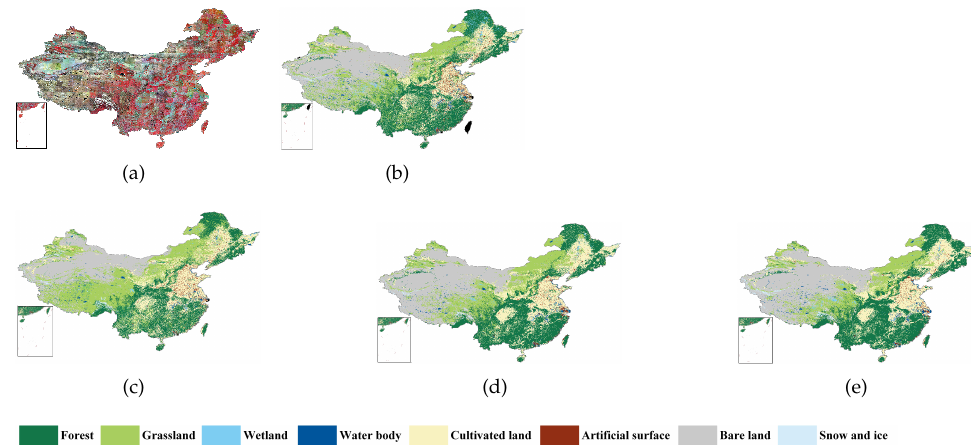
Figure 9. Original Landsat images for 2010 and corresponding land cover maps, where ( a ) is composed of 1056 Landsat 5 image with obvious stitching lines (https://earthexplorer.usgs.gov, accessed on 10 December 2017); ( b ) is the Land Cover Map of People’s Republic of China with an overall accuracy between 86% to 94% (http://www.geodata.cn, accessed on 10 December 2017); ( c ) is the GlobalLandCover 30 (GLC30) with an overall accuracy about 80% [63]; ( d ) is the land cover map produced by PSPNet and ( e ) is the land cover map produced by the proposed